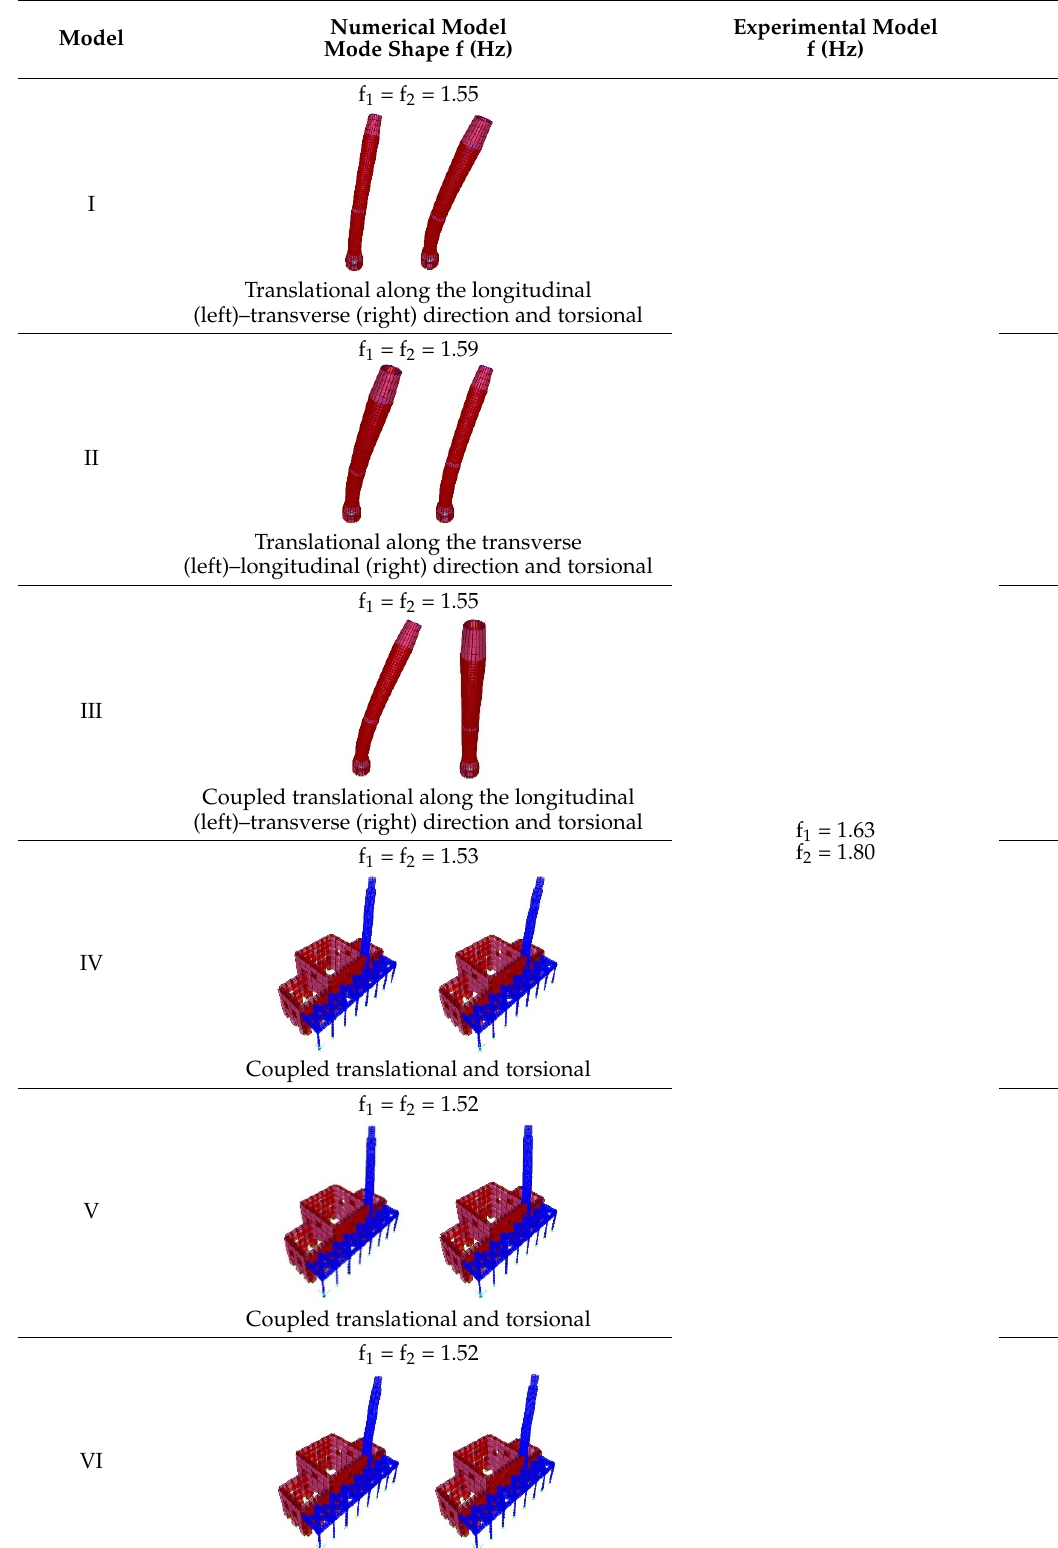
Table 4. Deviation of the eigenfrequencies between the experimental models and FEMs.